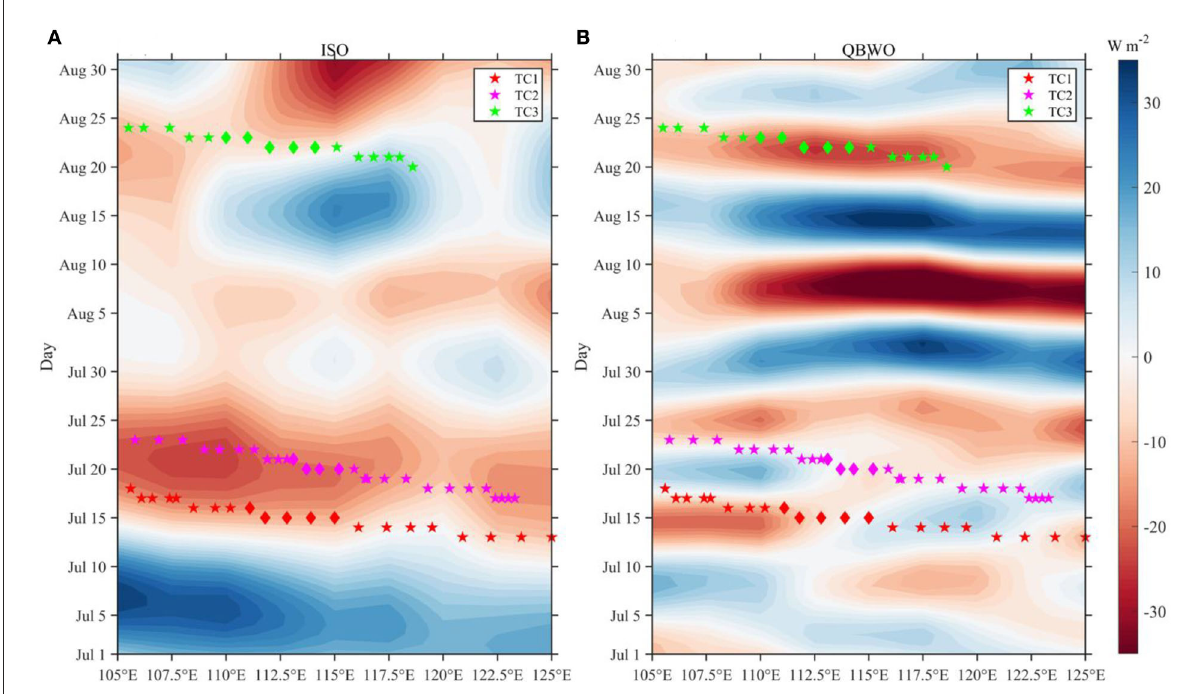
FIGURE6 (A) Longitude-time series of ISO (shading; units: W m − 2 ), averaged 10 ◦ N − 20 ◦ N. (B) Longitude-time series of QBWO (shading; units: W m − 2 ), averaged 10 ◦ N − 20 ◦ N. Red, purple, and green stars represent the zonal location of TC1/Conson, TC2/Chanthu, and TC3/Mindulle, respectively. Red, purple, and green diamonds represent the zonal location of TCs passing over the warm